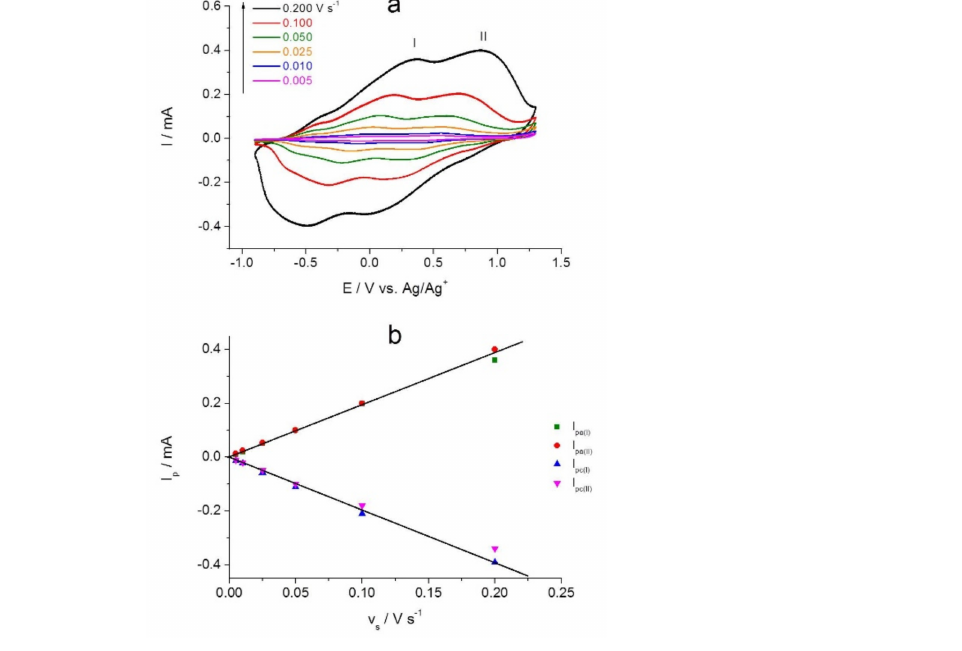
Figure 7. ( a ) CV curves of poly-[NiAmben] (see Figure 6 caption for polymerization conditions) in 0.05 M Et 4 NBF 4 /DCE at 0.005–0.2 V s − 1 scan rates; ( b ) dependencies of peak currents I p on the scan rate v s .